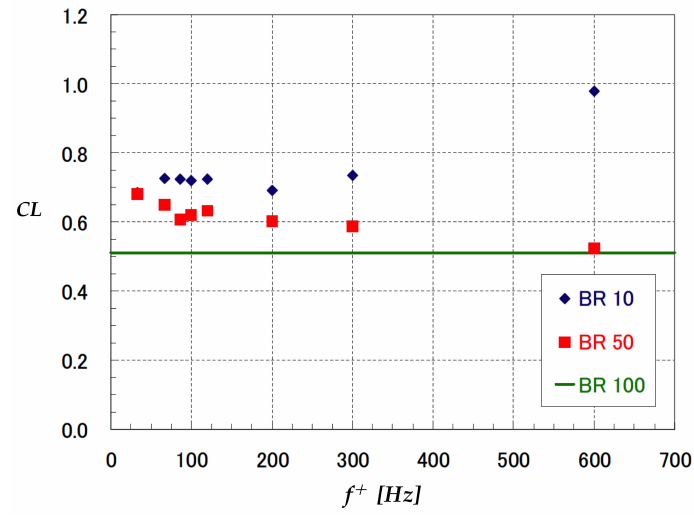
Figure 5. Burst frequency effect over the lift coefficients C L (Experiment): NACA0015, α = 12 ◦ , Re = 6.3 × 10 4 , Vpp = 4.0 kV. Reproduced with permission from [13], AIAA,